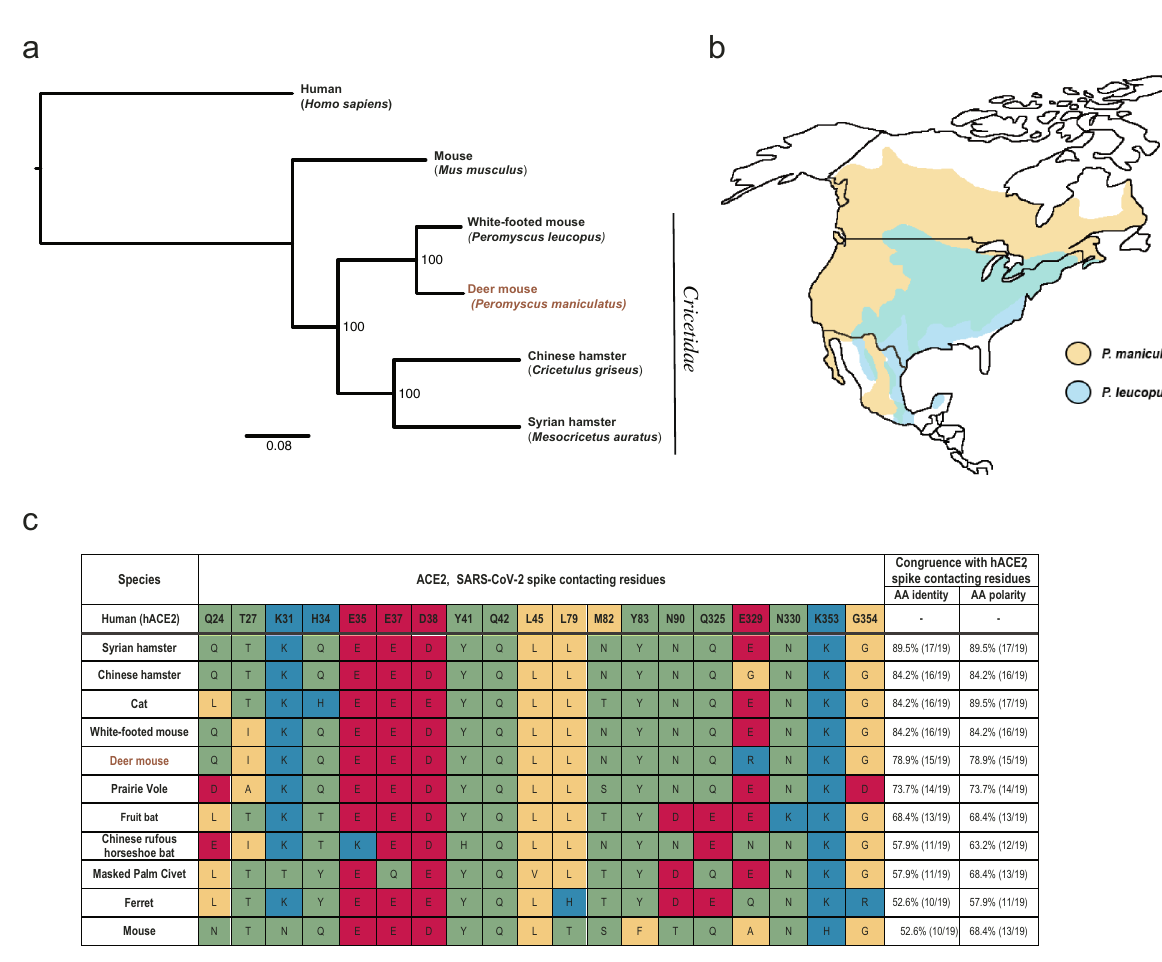
Fig. 1 Deer mouse range and predicted susceptibility to SARS-CoV-2. a Phylogeny showing the relationships among selected members of the Cricetidae family with mice and humans. b Geographical distribution of deer mice (based on data from Hall, 1981) 43 . c Alignment of human ACE2 (hACE2) amino acid residues known to confer ef fi cient binding of the RBD of SARS-CoV-2 spike with the corresponding ACE2 amino acid residues from selected members of the Cricetidae family and other naturally or experimentally susceptible host species. The physiochemical properties of the amino acids residues are indicated: nonpolar (yellow), polar (green), acidic (red), and basic residues